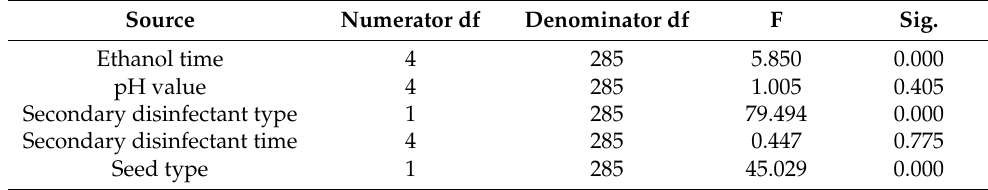
Table 6. A mixed model ANOVA on the seedling survival percentage of Suaeda aralocaspica .